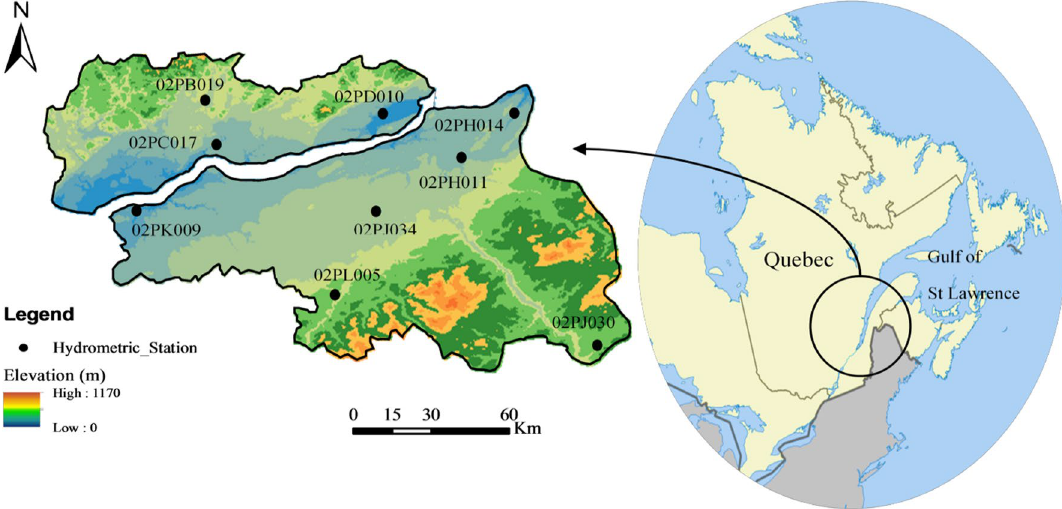
Fig. 1 Location and elevation map of the study area and hydrometric